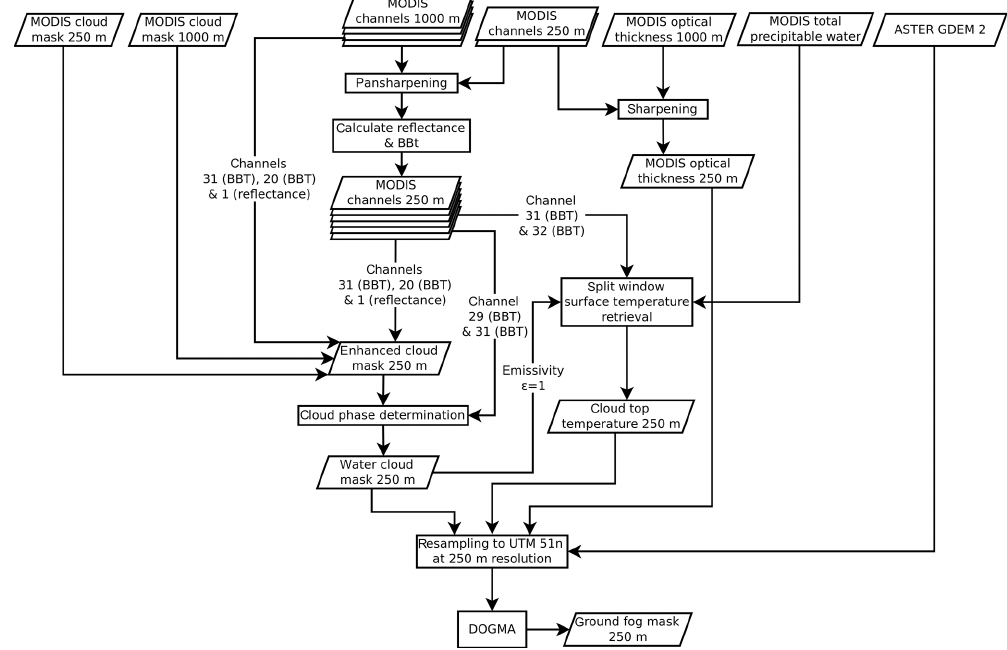
Figure 6. Flowchart for the processing of the inputs required to run